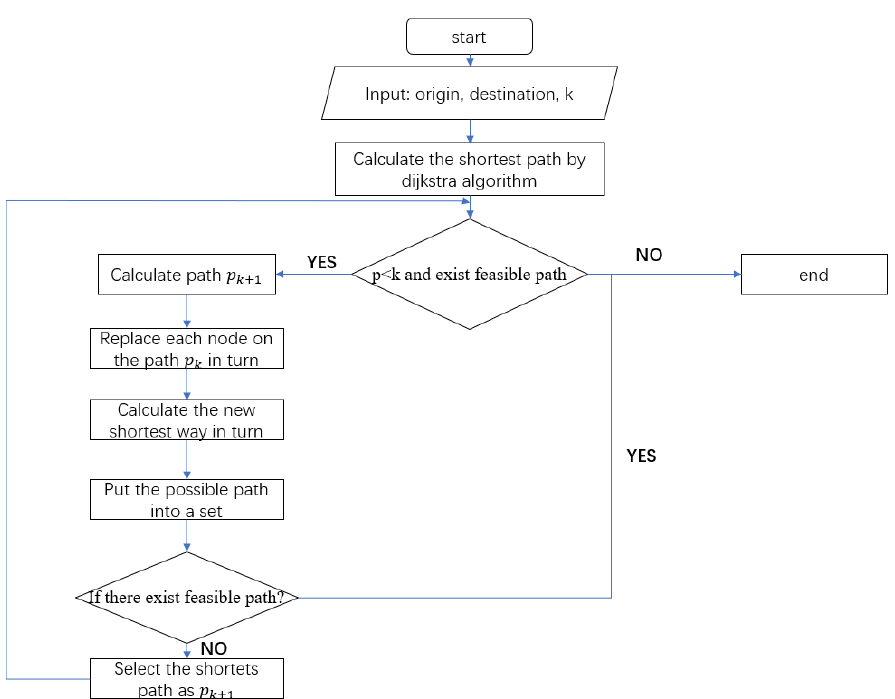
Figure 6. Flowchart to find the k-shortest paths in MiRN.